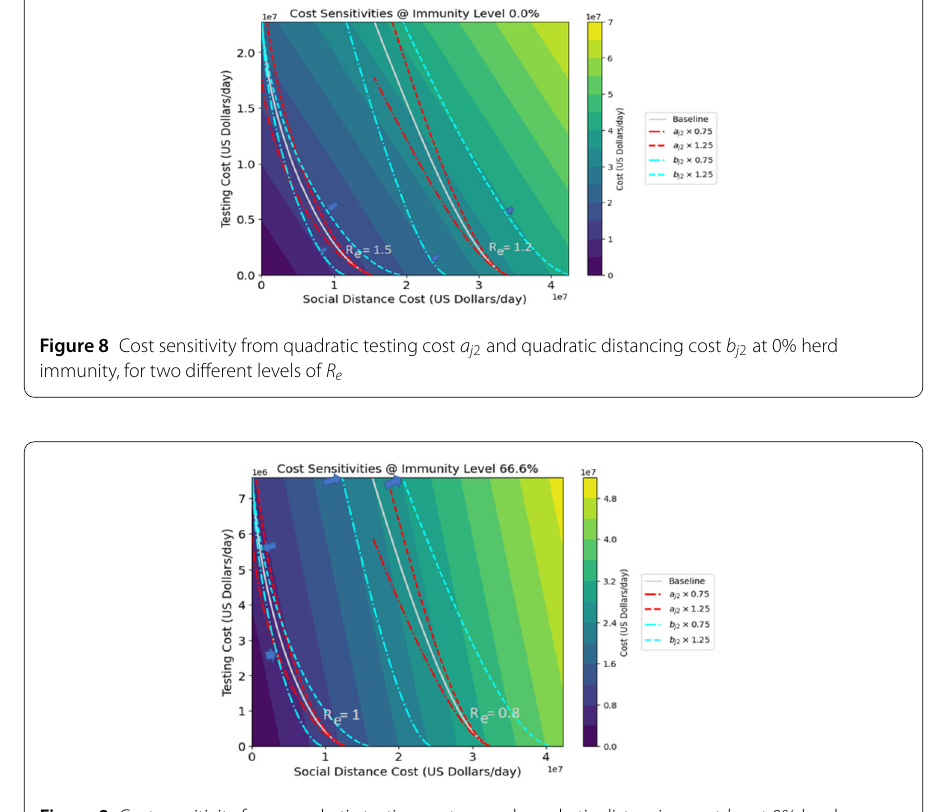
Figure 9 Cost sensitivity from quadratic testing cost a j 2 and quadratic distancing cost b j 2 at 0% herd immunity, for two different levels of R